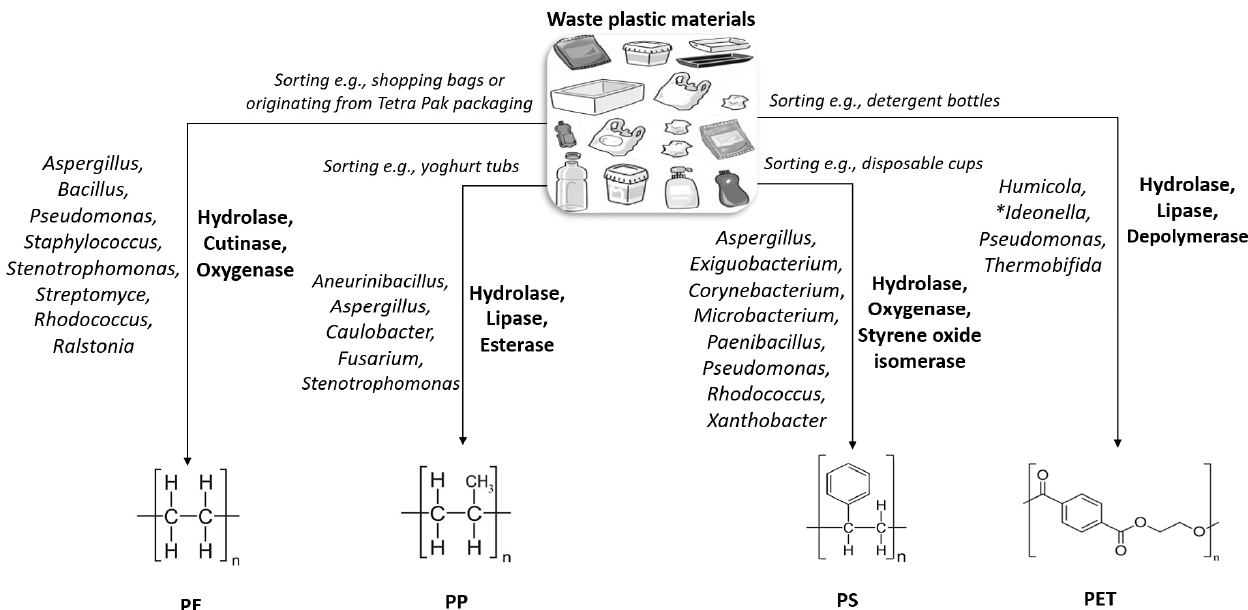
Figure 4. Microbes and major enzymes (in bold) involved in plastic material breakdown. The bio- chemical pathways involved with *Ideonella are explained further in Section 3.5